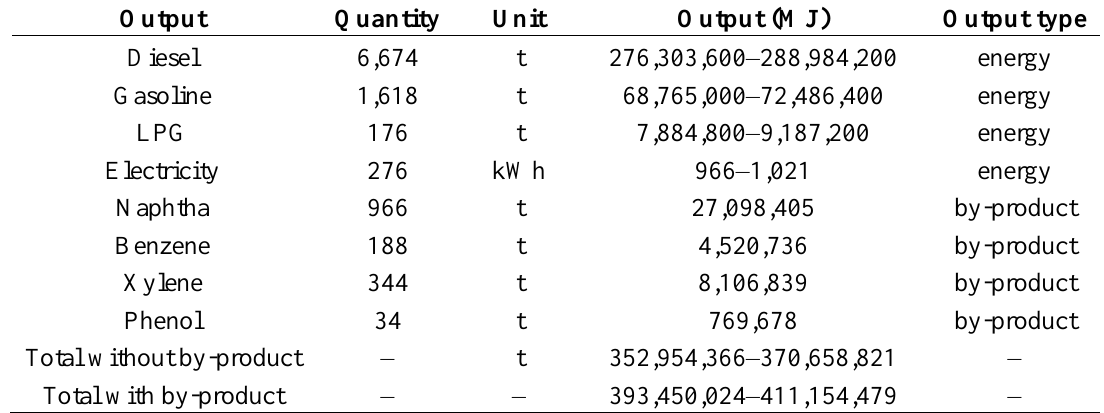
Table 1. Primary energy outputs per 10,000 tonnes of DCL products and our conversion to MJ [25].